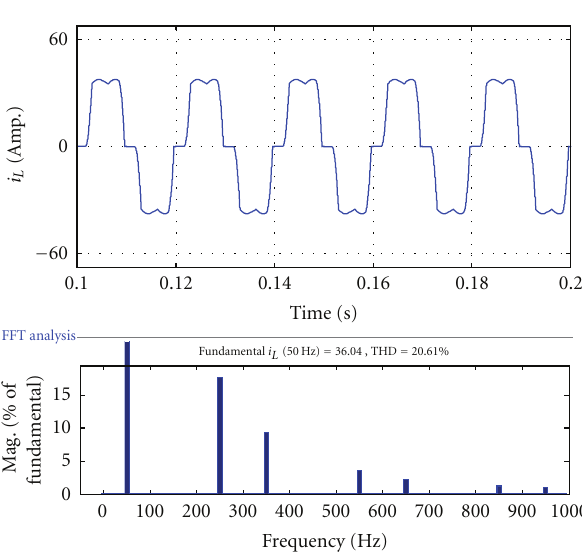
Figure 7: Load current waveform along with its THD. Table 1: System parameter values used for simulation.